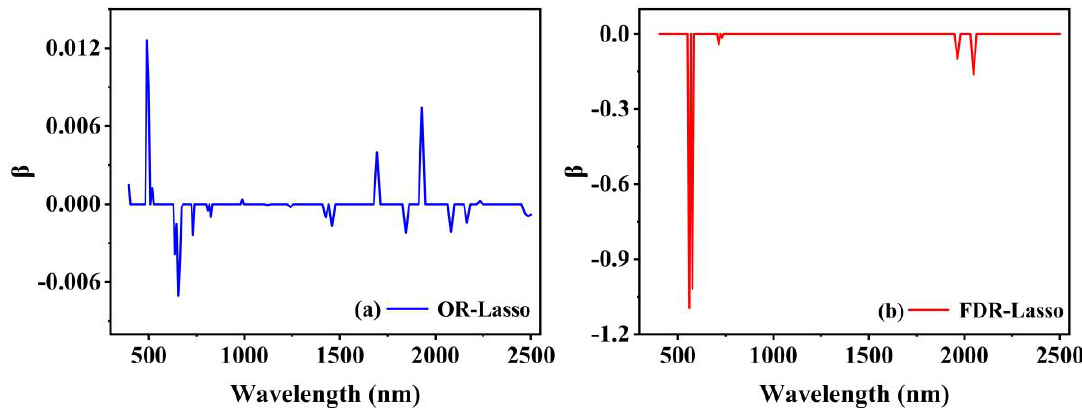
Figure 5. Lasso characteristic spectral band selection (( a ) OR-Lasso characteristic selection; ( b ) FDR- Lasso characteristic selection). Table 4. Lasso feature selection band number and